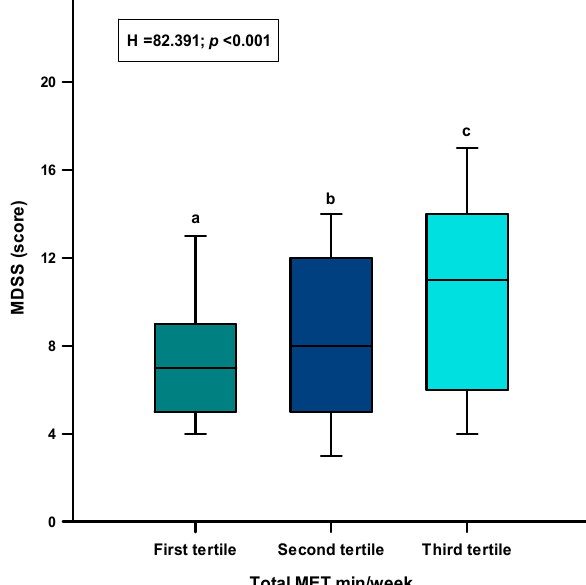
Figure 5. Difference of the total MDSS score between the tertiles of the IPAQ-SF results. Tested using one-way analysis of variance on ranks with the post-hoc Dunn’s test to examine the differences between each group. a vs. b = p < 0.05; a vs. c = p < 0.05; a vs. d = p < 0.05; d vs. b = p < 0.05; d vs. c = p < 0.05.